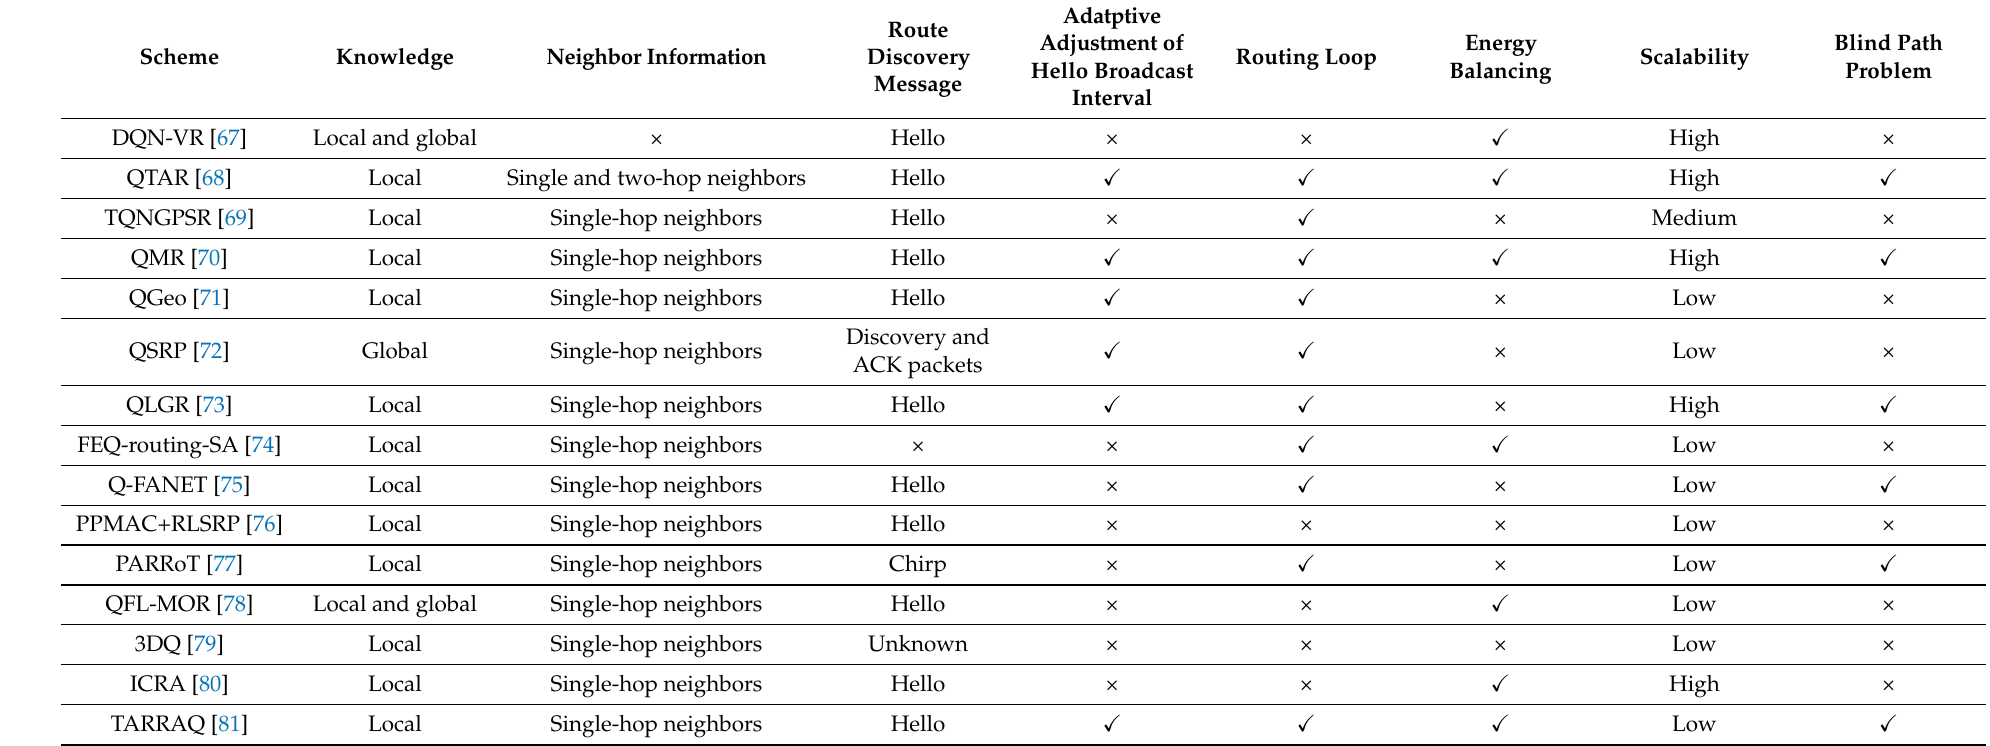
Table 23. Comparison of RL-based routing